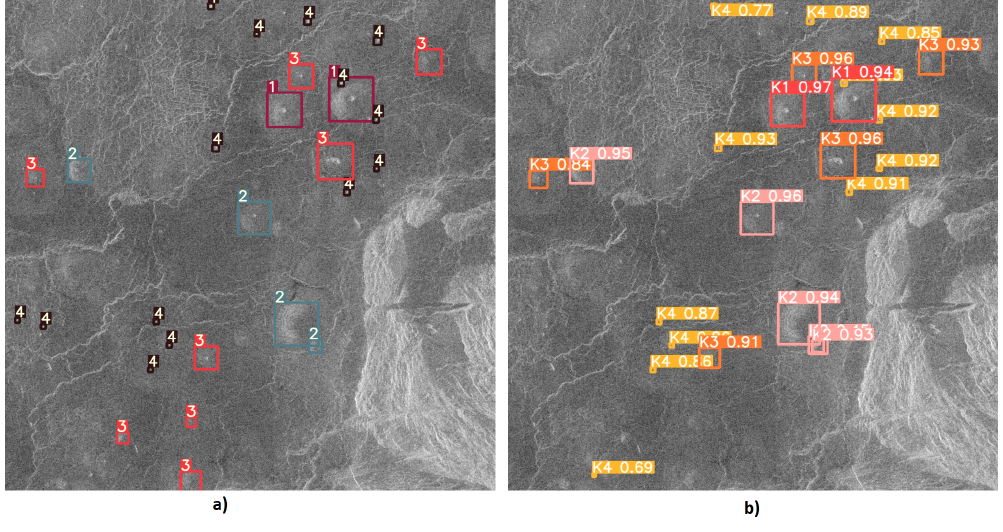
Figure 17. Input and output image used for testing the model-1: ( a ) Input image with given objects for detection. ( b ) Output image with detected objects.